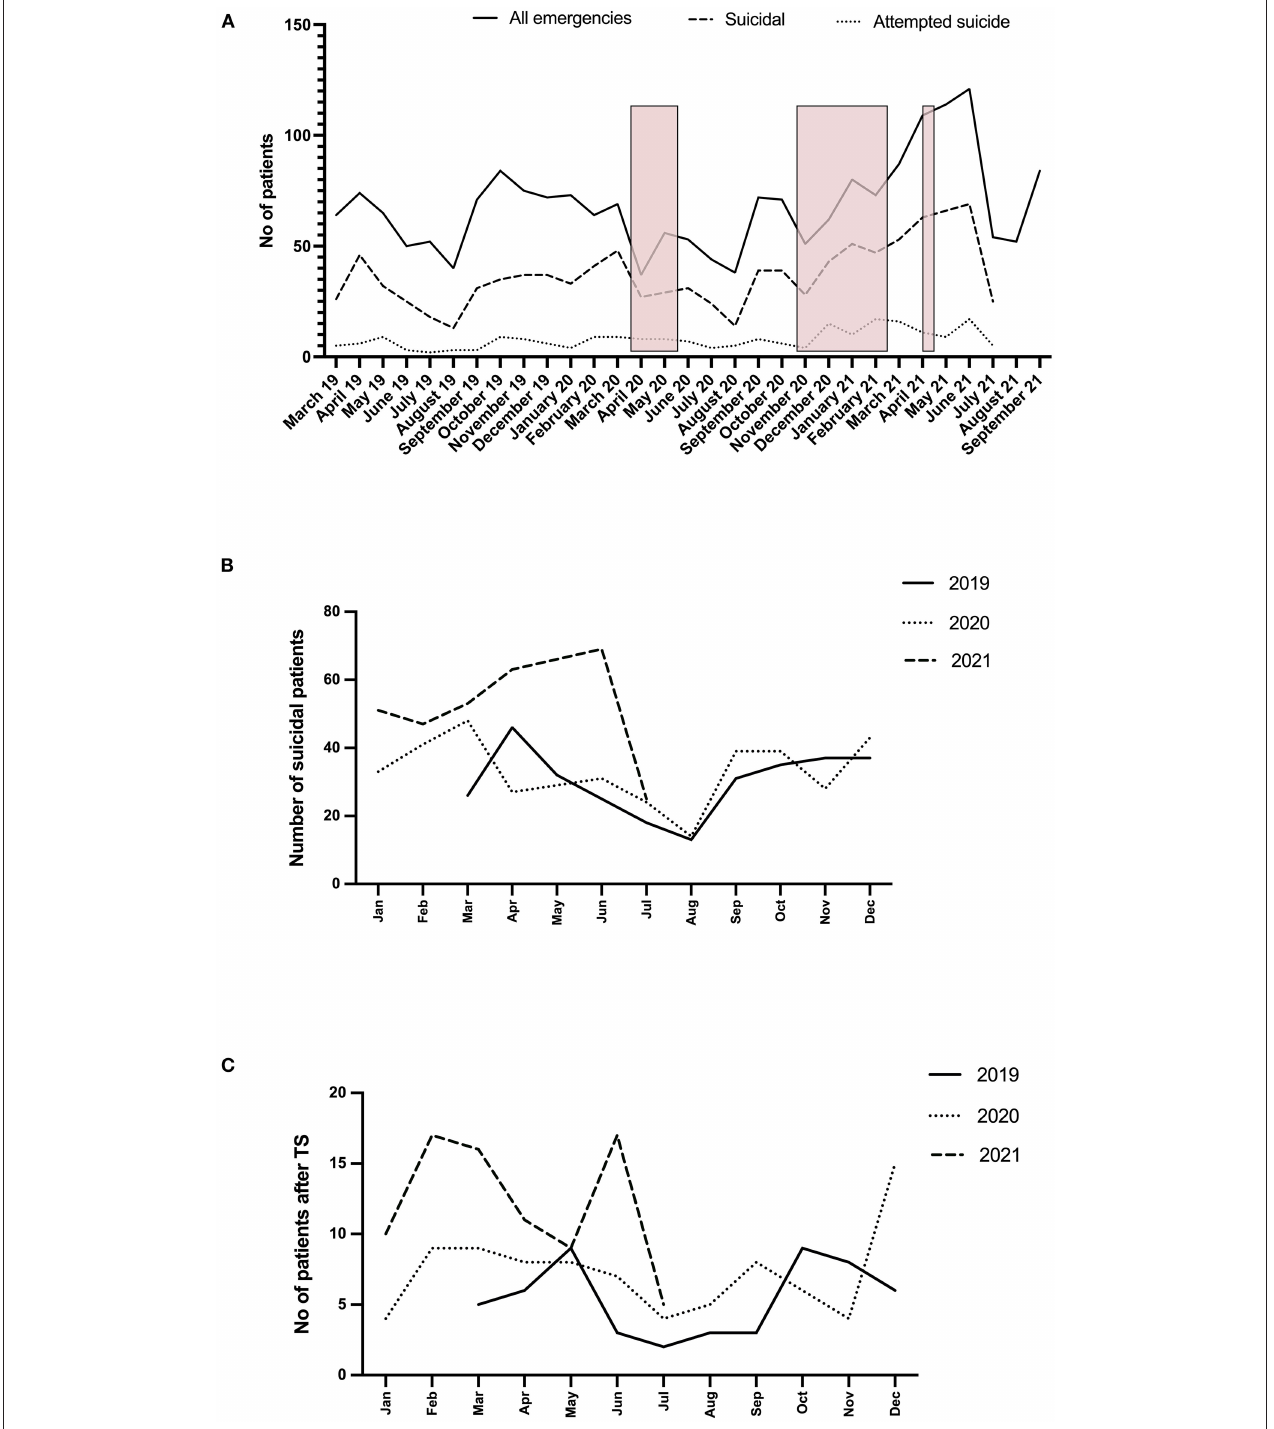
FIGURE 1 | Time course of monthly emergency service assessments (outpatient and inpatient) from the beginning of March 2019 until the end of July 2021. (A) The number of all the assessed patients (through the end of September 2021), suicidal patients (suicidal ideation + attempted suicide) and patients after attempted suicides for given months. The pink squares represent the months with school closures due to the pandemic restriction measures. (B) Comparison of the number of suicidal patients (suicidal ideation + attempted suicide) for the comparative months over three consecutive years – before and during the COVID-19 pandemic. (C) Comparison of the number of patients assessed after attempting suicide (TS) for the comparative months over three consecutive years – before and during the COVID-19 pandemic.